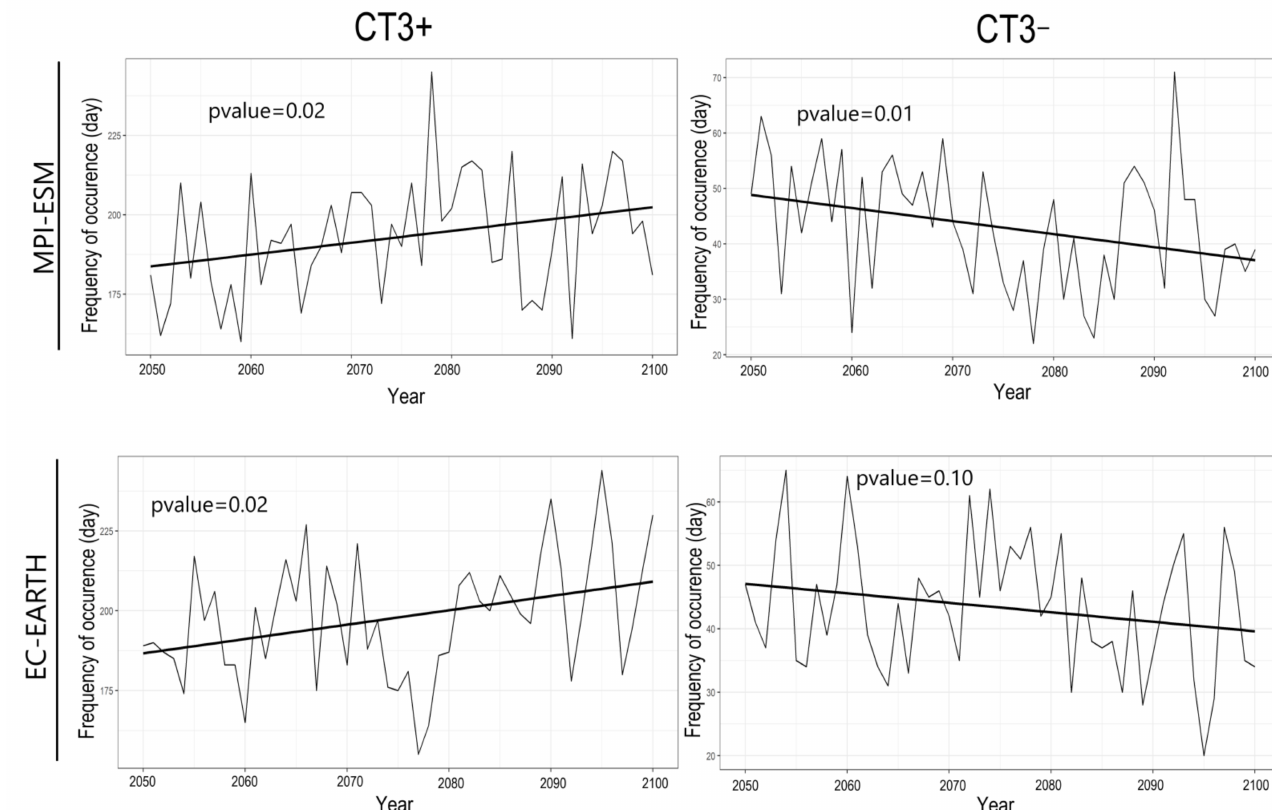
Figure 12. Simulated trends in CT3+ and CT3 − from the GCMs, under the ssp585 scenario for the 2050–2100 analysis period. The p -values from the Mann–Kendal test are written in the